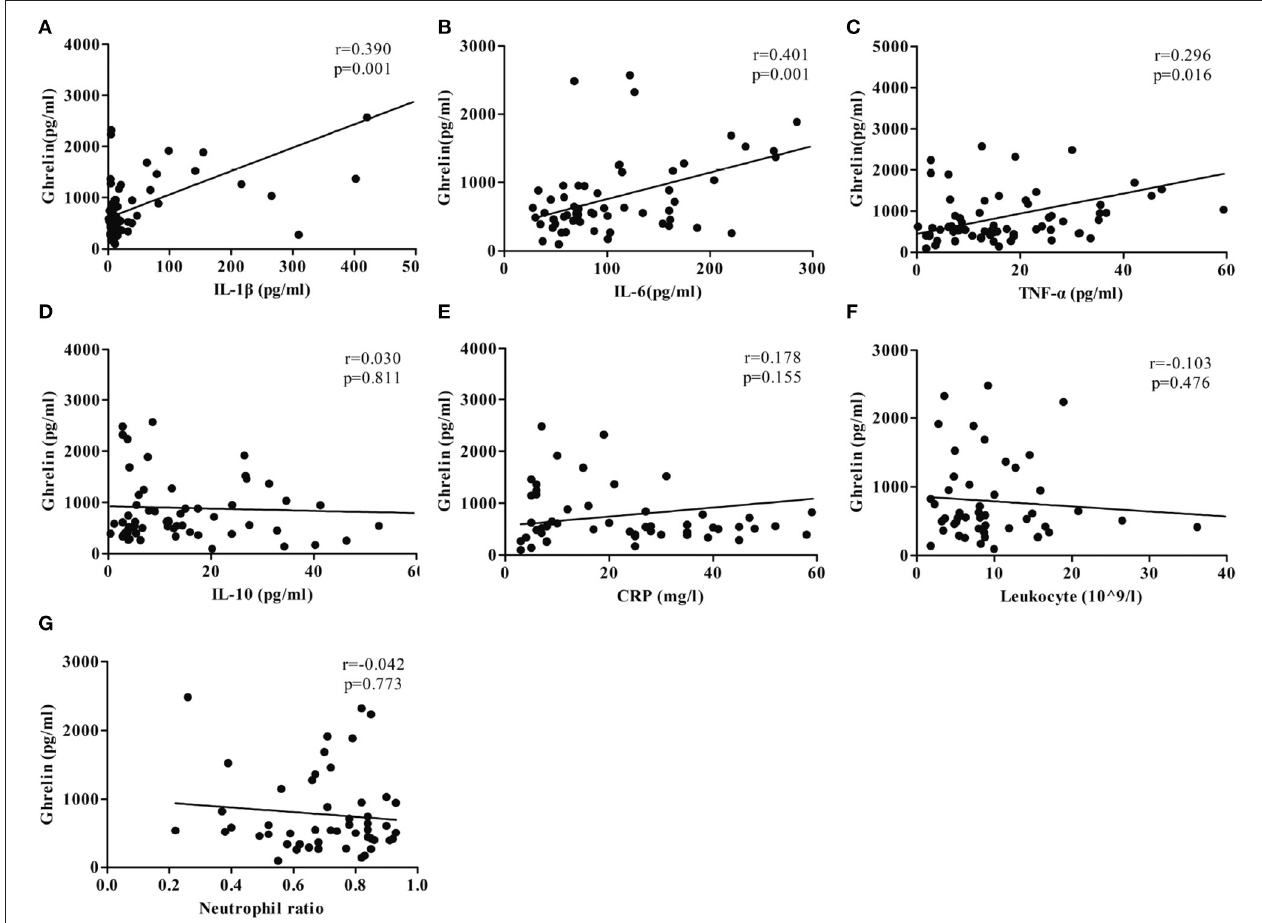
FIGURE 3 | Correlation between the ghrelin level and plasma concentrations of inflammatory factors. (A) IL-1 β . (B) IL-6. (C) TNF- α . (D) IL-10. (E) CRP. (F) Leukocyte (109/L). (G) Neutrophil ratio.